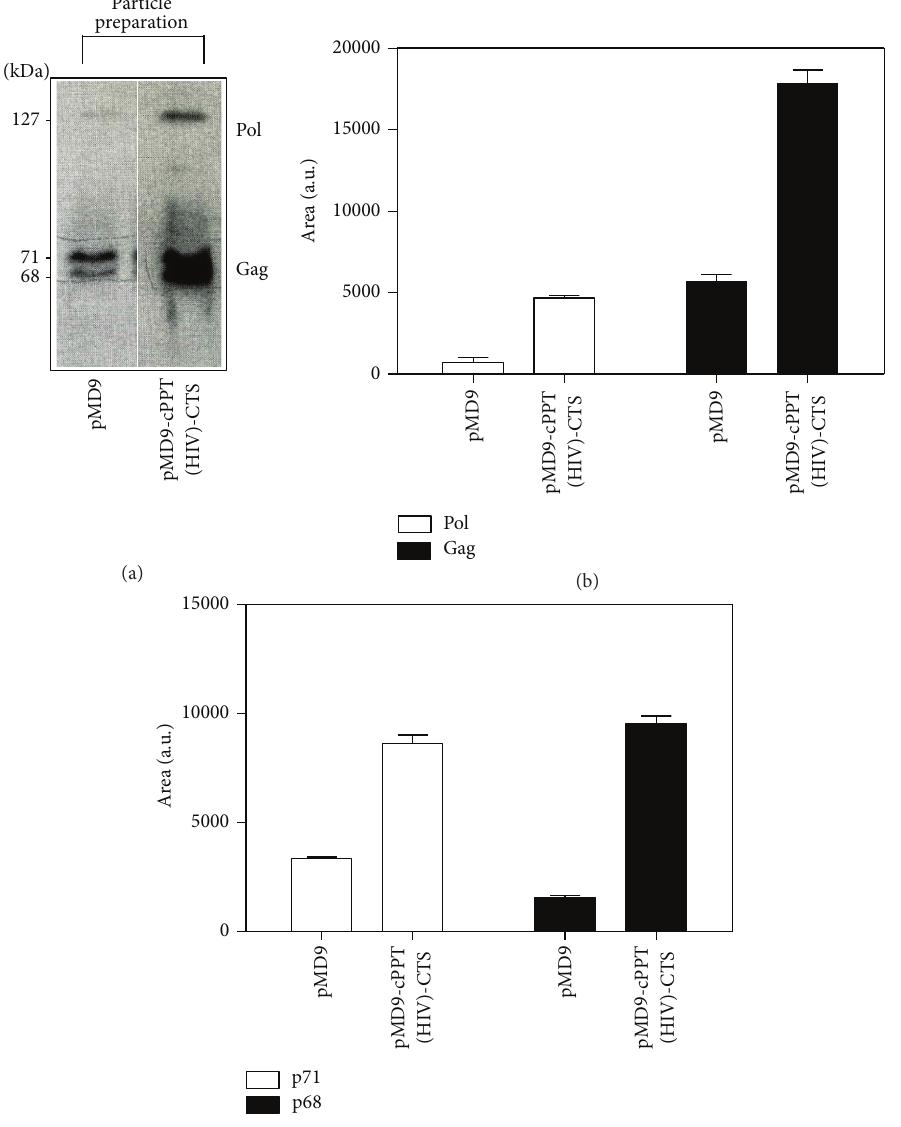
Figure 6: Analysis of pMD9 parental vector and its modification (pMD9-cPPT (HIV)-CTS). Detection of PFV proteins in partially purified viral particles produced by HEK 293T cells (a) contransfected with the retroviral vectors was measured quantitatively for Gag/Pol (b) and Gag fractions (p71, p68) (c). The mean ± SD values from three independent assays are shown. The area is measured in arbitrary units, which are abbreviated as